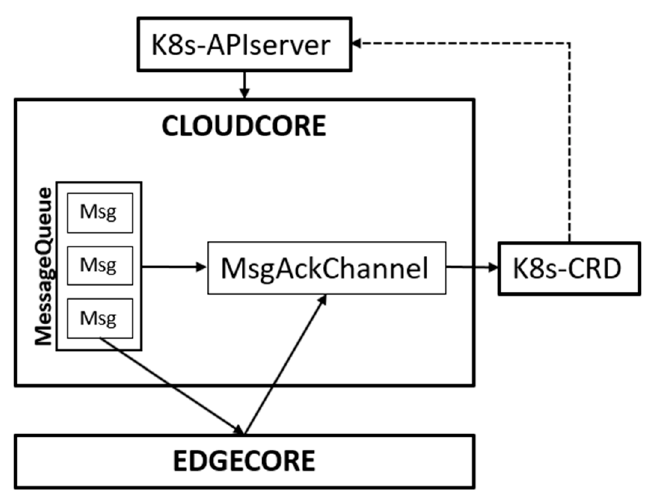
Figure 2. KubeEdge Cloud-Edge transmission reliability design.